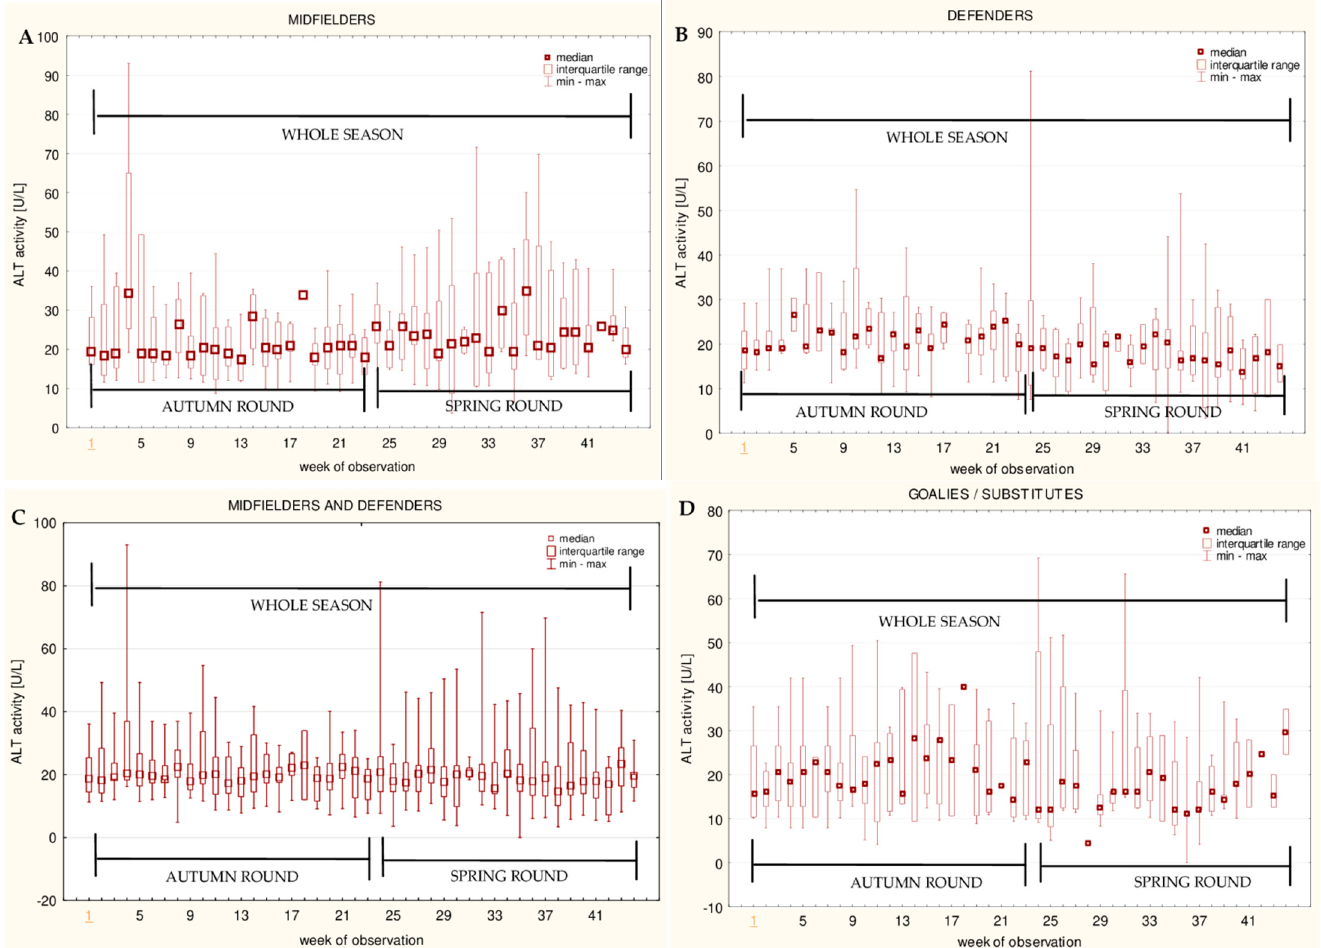
Figure 2. Median alanine aminotransferase (ALT) activities in: ( A ) The midfielder, ( B ) defender, ( C ) midfielder/defender and ( D ) goalie/substitute subgroups over the course of the soccer match season.